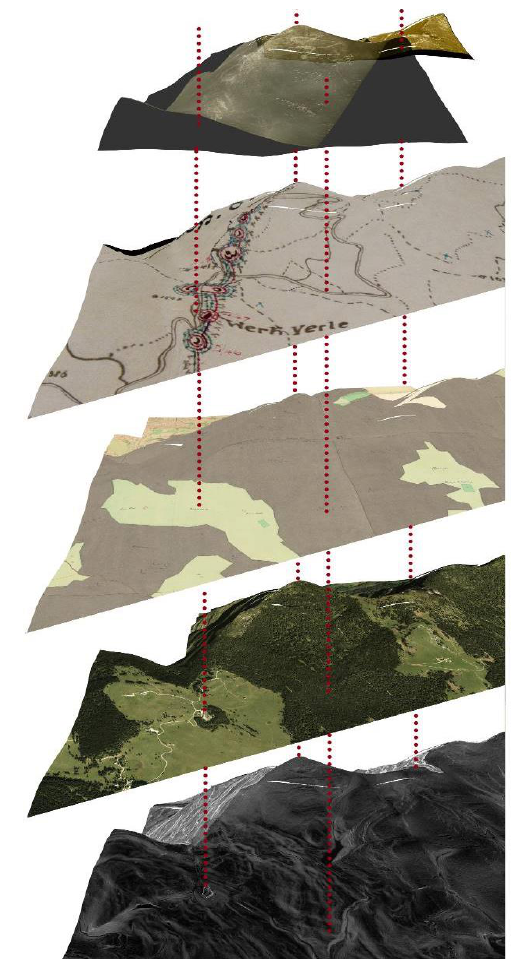
Figure 4 . Overlapping of different temporal layer: DTM, orthophotographs 2015, Austro-Hungarian